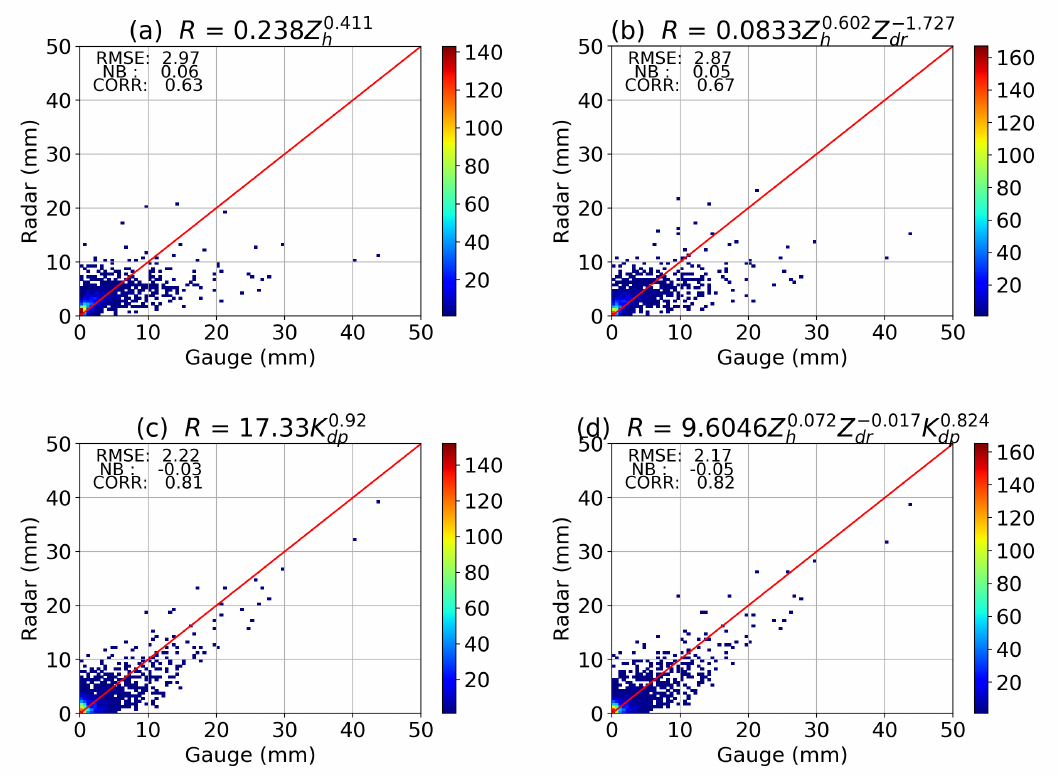
, h K 0.824 Z − 0.017 . The data were dp h dr